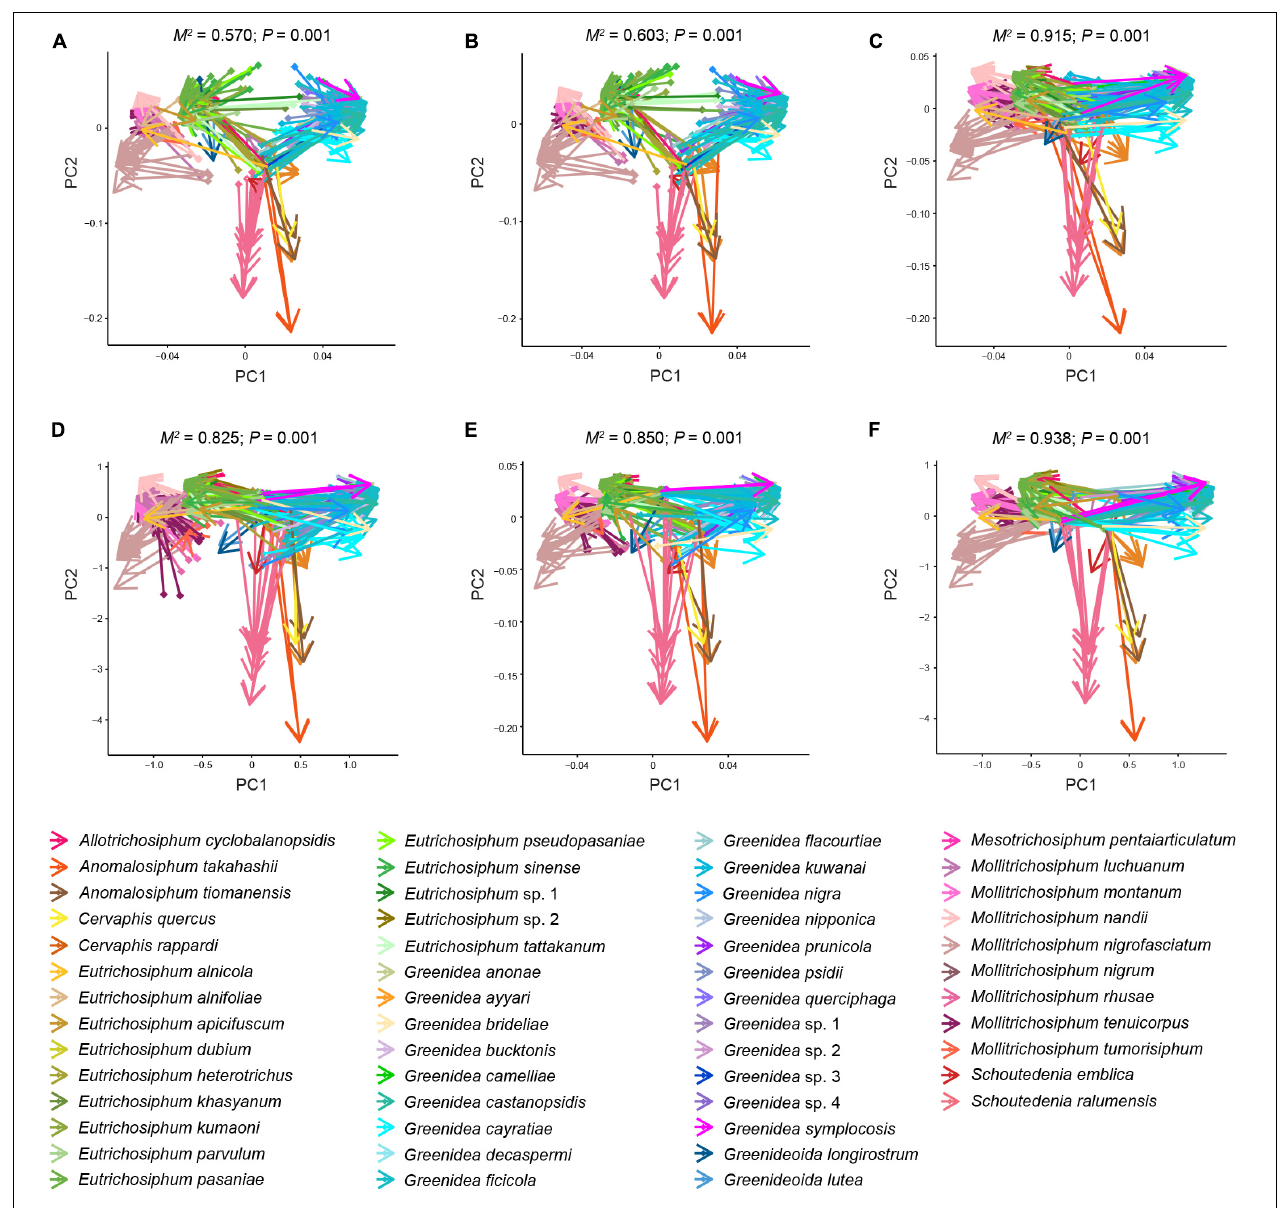
FIGURE 5 | Procrustean superimpositions for PCA-scaled aphid cophenetic distances vs. variations in bacterial (A,D) , symbiont (B,E) , and secondary symbiont (C,F) communities. Bray–Curtis (A–C) and unweighted UniFrac distances (D–F) were used to estimate the microbiota